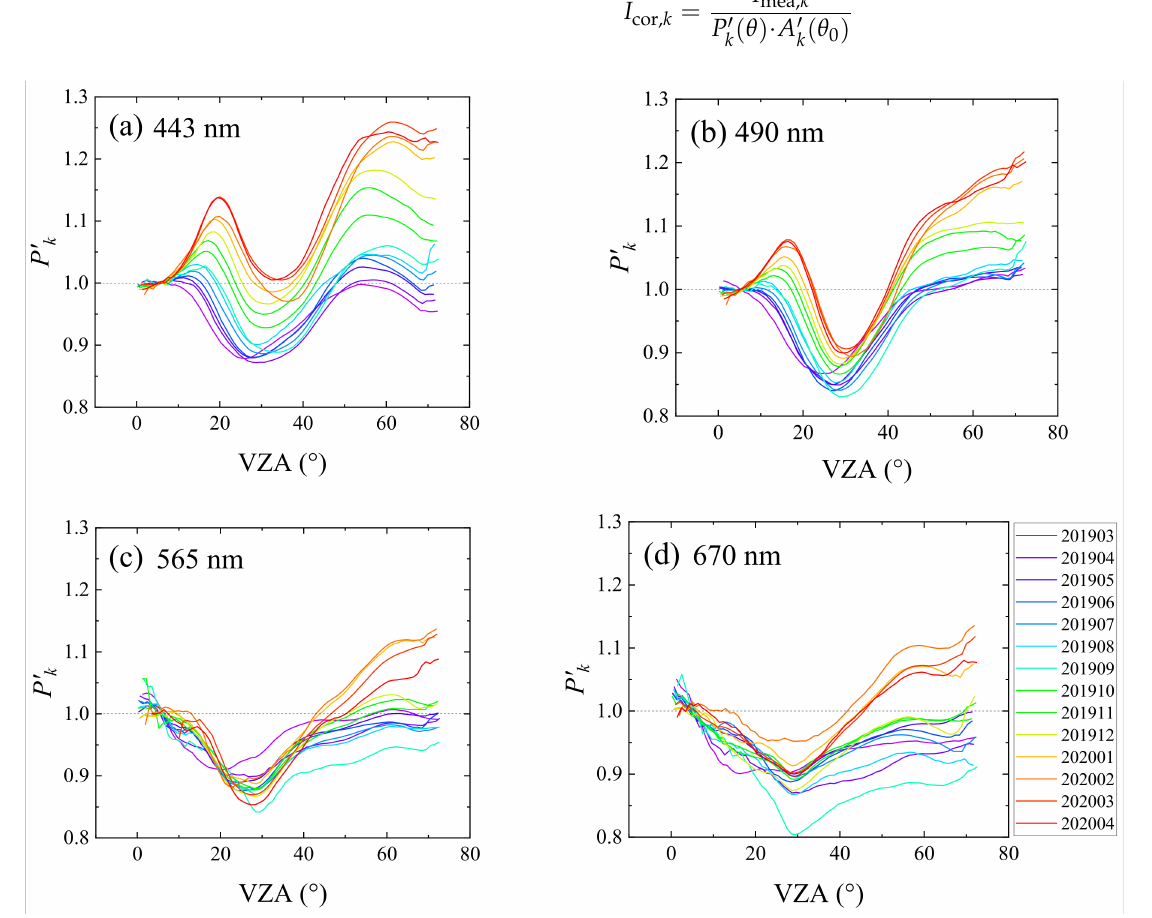
( θ ) varing with the VZA, from March 2019 Figure 6. The relative radiometric calibration results of P (cid:48) k to April 2020 for ( a ) 443 nm, ( b ) 490 nm, ( c ) 565 nm and ( d ) 670 nm bands of DPC/GaoFen-5. The ( θ is normalized by the average A (cid:48) ( θ ) for VZA less than 10 ◦ . A (cid:48) k k Table A1. Most of the polynomial fitting correlation coefficients R 2 are larger than